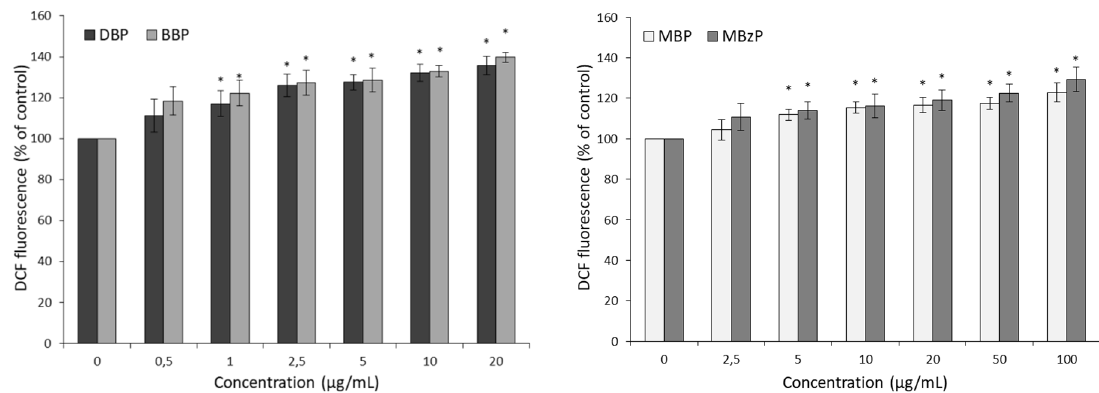
Figure 2. Changes in reactive oxygen species levels in control erythrocytes and in erythrocytes incubated for 6 h with DBP, BBP, MBP, and MBzP used at concentrations ranging from 0.5 to 100 µg/mL. (*) p < 0.05.